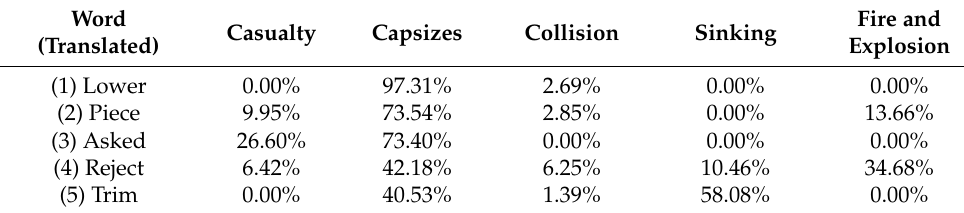
Table 6. Latent-cause words in complex collision accidents in the category of “capsizes.”